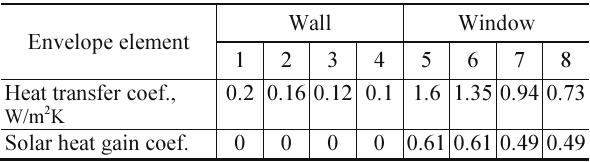
Table 2. Characteristics of different envelope elements Envelope element